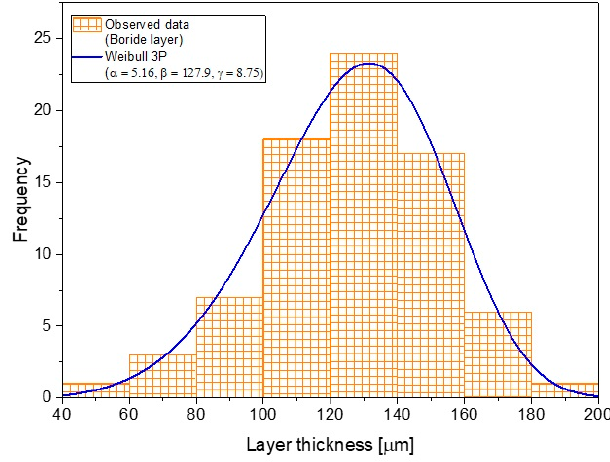
Figure 11. Boride layer thickness histogram fitted to Weibull 3P.